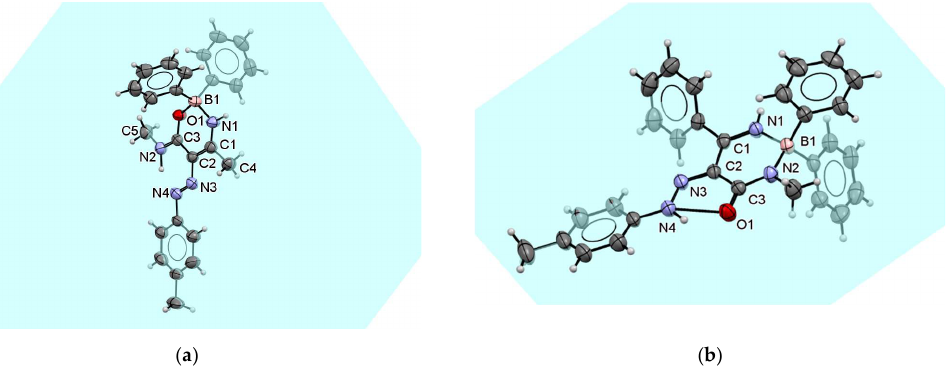
Figure 13. ORTEP diagram of the oxazaborine 6e crystal ( a ); and ORTEP diagram of the diazaborinone 7f crystal ( b ). 7f crystal ( b